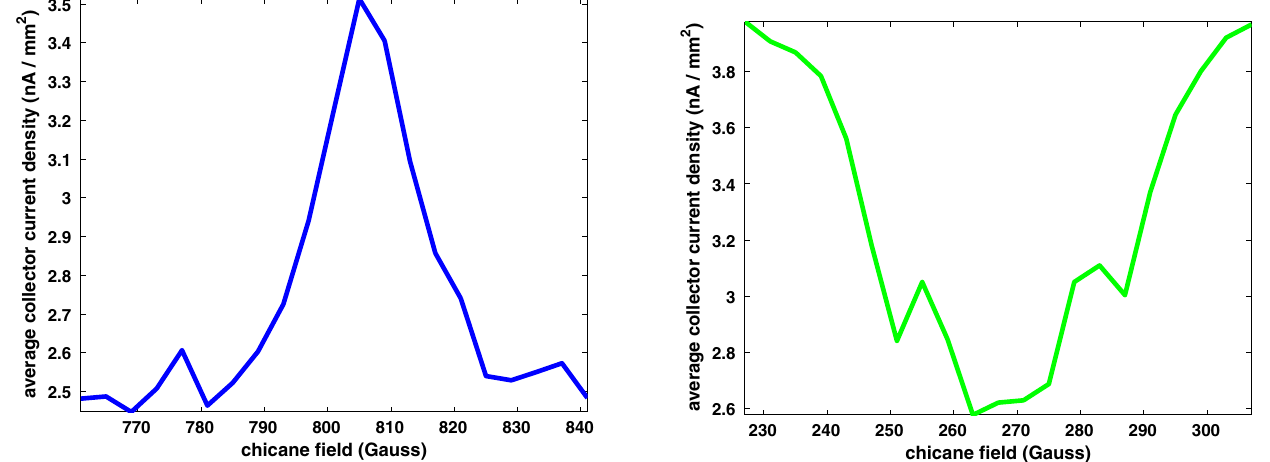
FIG. 13. Simulation of cyclotron resonances observed by an RFA in aluminum (left) and TiN (right) chambers, 1 × 45 × 1 mA e þ , 4 ns, 5 GeV. Note that, as in Fig. 7, the resonance appears as an increase in the aluminum chamber signal, but a decrease in the TiN chamber signal.